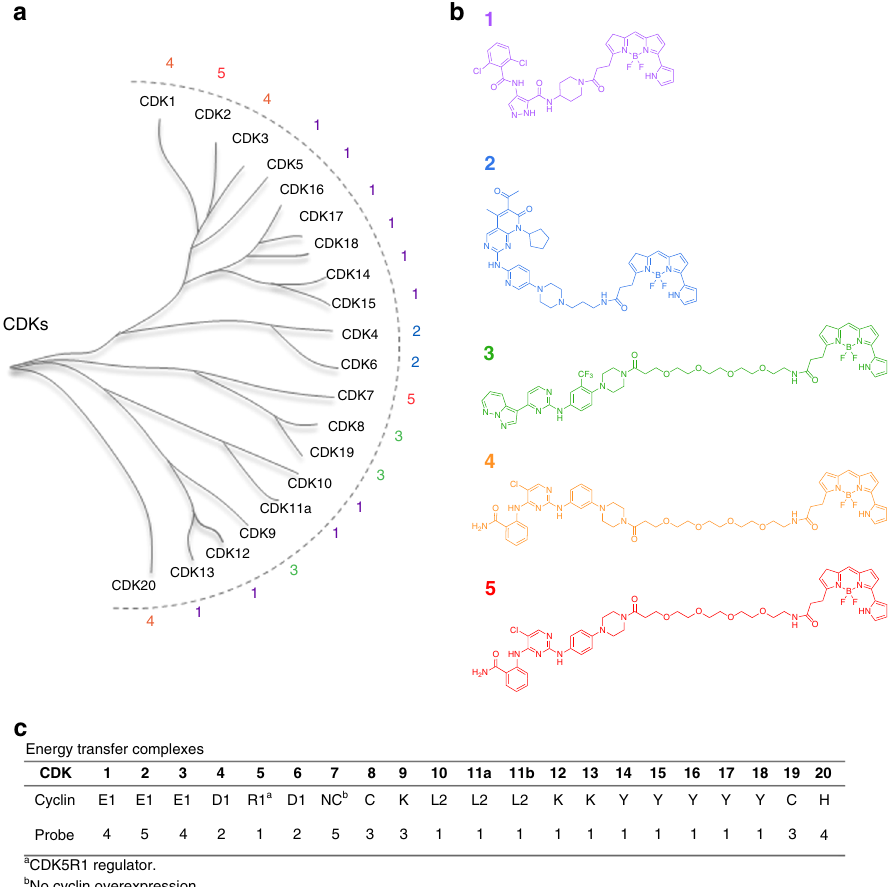
Fig. 1 Comprehensive energy transfer system for all 21 human CDKs in live cells. a CDK phylogenetic tree 4,5,8 . b Cell-permeable energy transfer probes used to comprehensively pro fi le CDK engagement in live cells. c Key components for each CDK assay are summarized and described in full in Supplementary Table 2. For simplicity, only CDK11A will be represented in the dendrograms throughout this manuscript. However, both CDK11A and CDK11B isoforms were